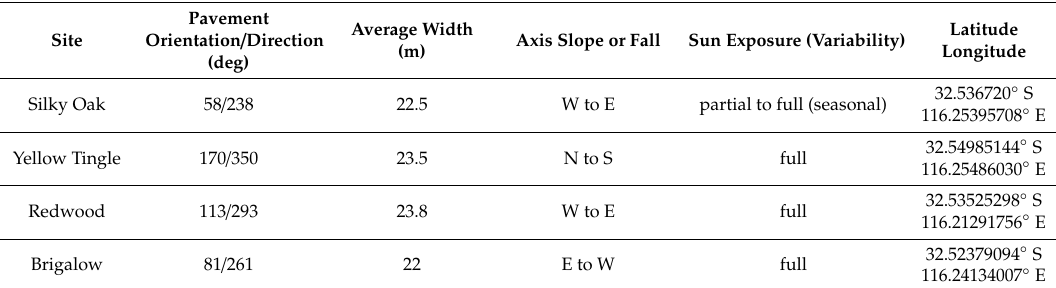
Table 1. Description of road sites used to test survival of Phytophthora cinnamomi in woody inoculum plugs at 10 and 50 cm. Sun exposure: partial (seasonal) = site shaded by adjacent vegetation for at least part of the day, mid-year.